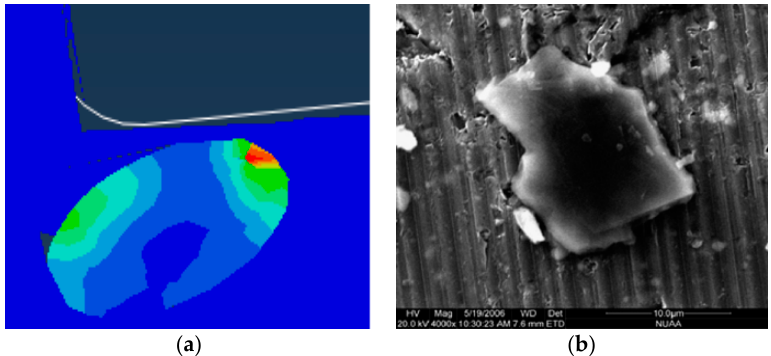
Figure 20. Particles pressed into the matrix: ( a ) Particle pressed into the substrate’s simulation topography, ( b ) particle pressed into the matrix topography during actual processing [37]. ( b ) Adapted with permission from ref. [37] Copyright 2018, Elsevier.